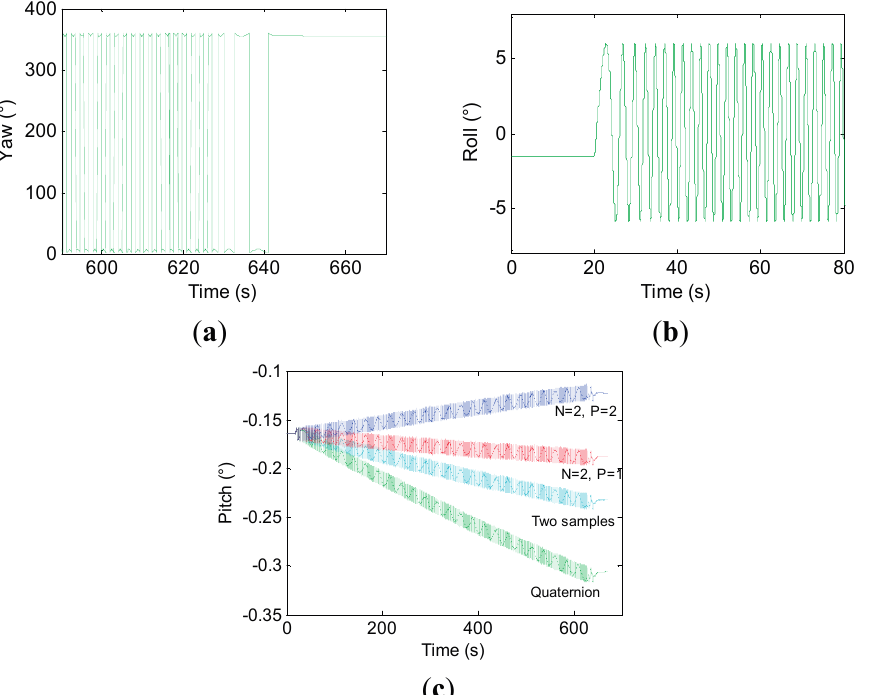
Figure 1. Compensation results of different coning correction algorithm. ( a ) Yaw, ( b ) Roll, ( c )